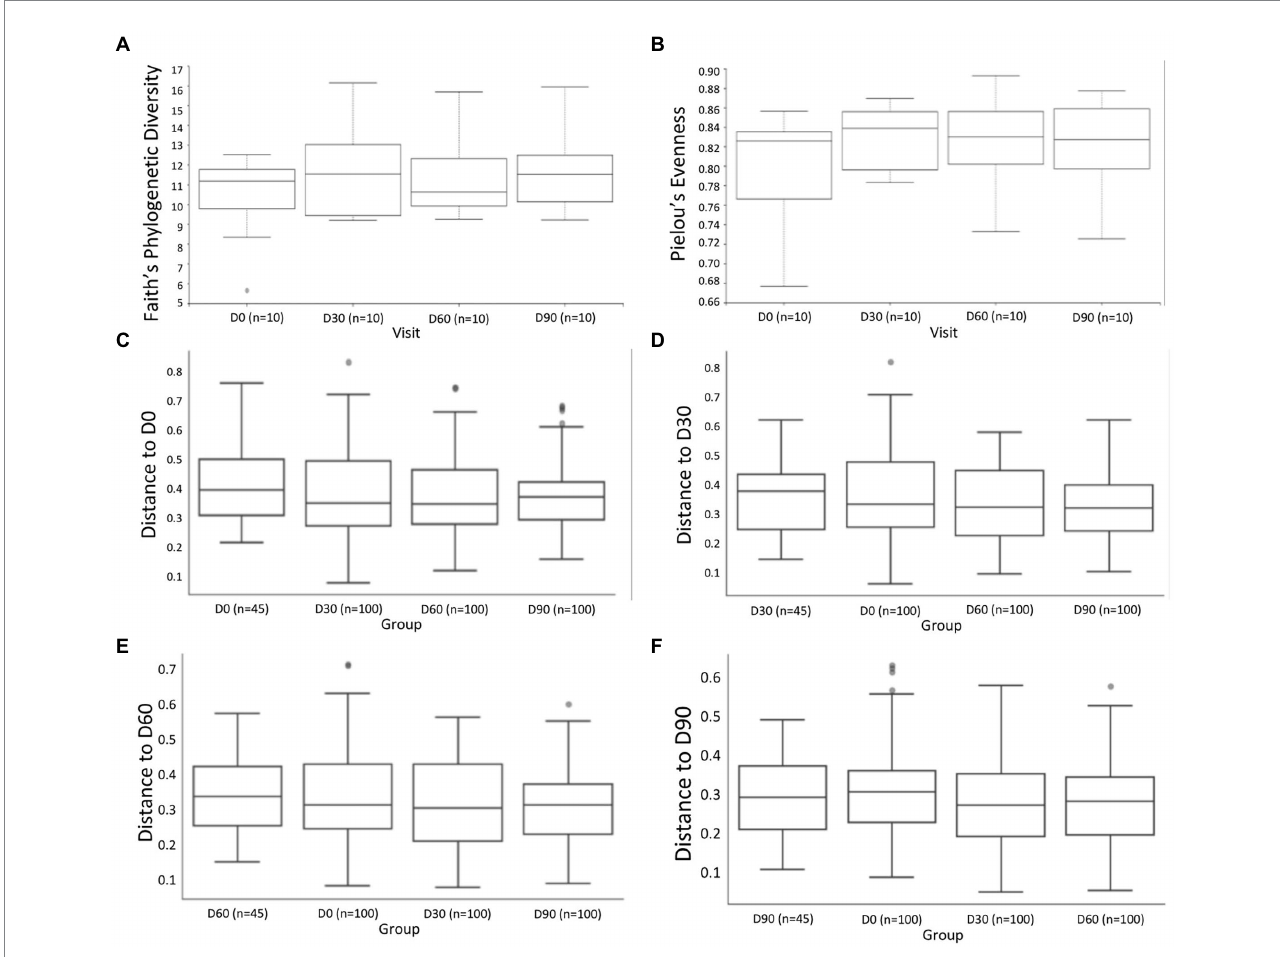
FIGURE 3 Alpha diversity metrics comparing community (A) richness and (B) evenness between study visits, respectively. Kruskal–Wallis pairwise comparisons with Benjamini–Hochberg False Discovery Rate (FDR) correction were performed. Beta diversity metrics included Weighted UniFrac (C–F) with PERMANOVA test (999 permutations) comparing community dissimilarity across study